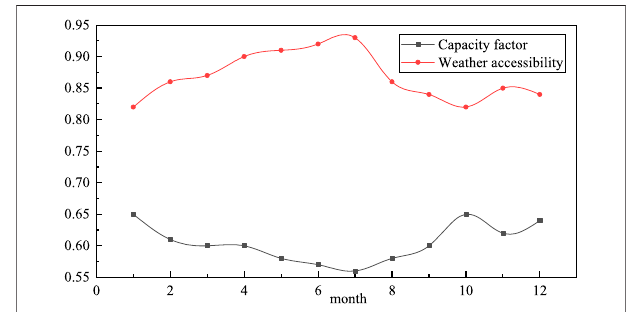
FIGURE 8 | Weather